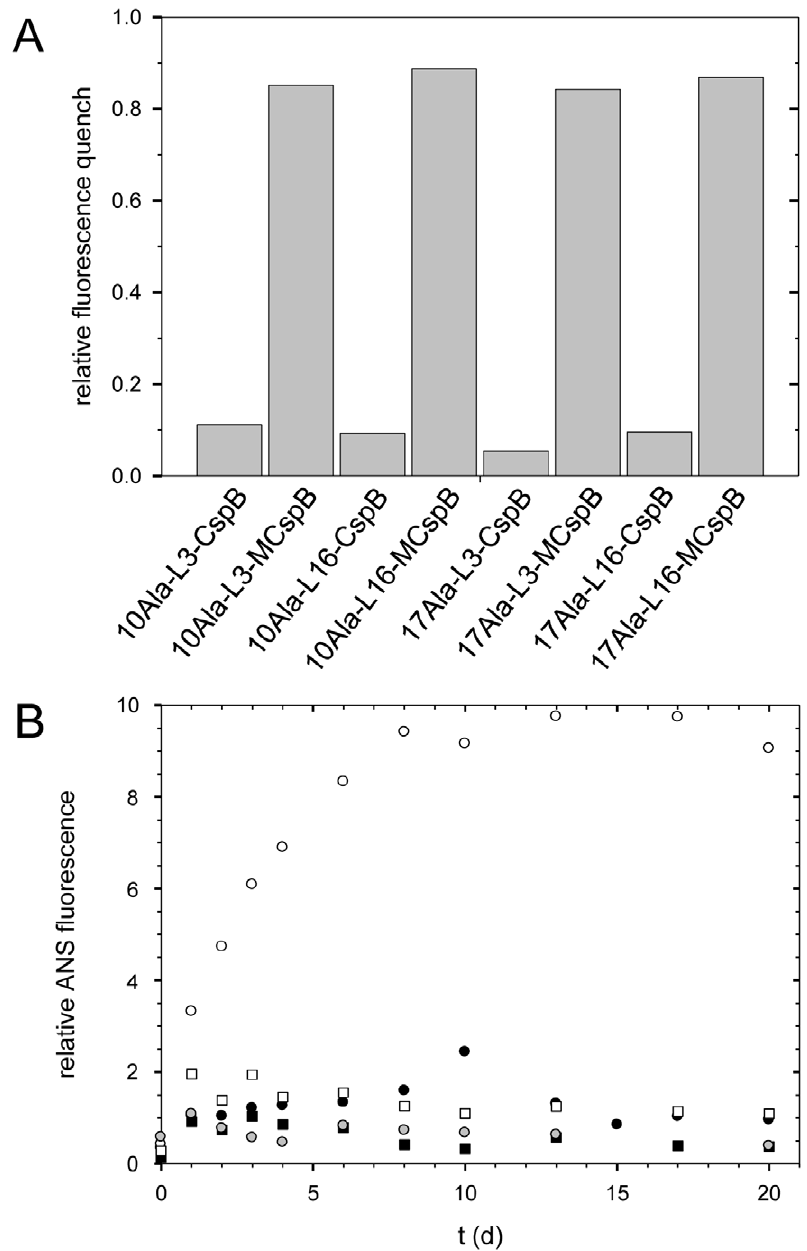
Figure 6. Fibril formation of fusions with MCspB. A Binding of dT7 to CspB in the fibrillation samples after 238 days. B Seeding of the variants with 10 alanines. Fibrillations with 5% seeds (w/w) derived from fibrils of 10Ala-CspB as shown with open symbols; fibrillations w/o seeds with filled symbols; 10Ala-L16-CspB (circles); 10Ala-L16-MCspB (squares); 5% seeds alone (gray circles). Fibrillations were performed at a protein concentration of 0.5 mM in KH 2 PO 4 , 100 mM NaCl, pH 7.5 at 37 u C. Table S1 Peptide fragments of the proteinase K digest- ed and solubilized fibrils of 10Ala-CspB. The highlighted